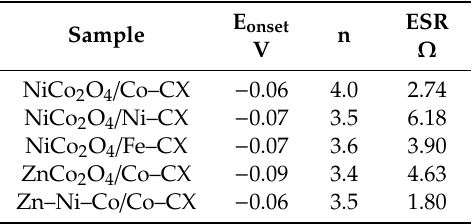
Figure 7. Linear sweep voltammograms (LSV) for ( a ) NiCo 2 O 4 / M-CX and ( b ) NiCo 2 O 4 / Co-CX, ZnCo 2 O 4 / Co-CX, and Zn-Ni-Co oxide / Co-CX at 4000 rpm. Table 6. Parameters obtained from LSV @ 4000 rpm (values of n refer to K-L fitting for data at − 0.8 V) and equivalent series resistance (ESR) calculated from the Nyquist plot.